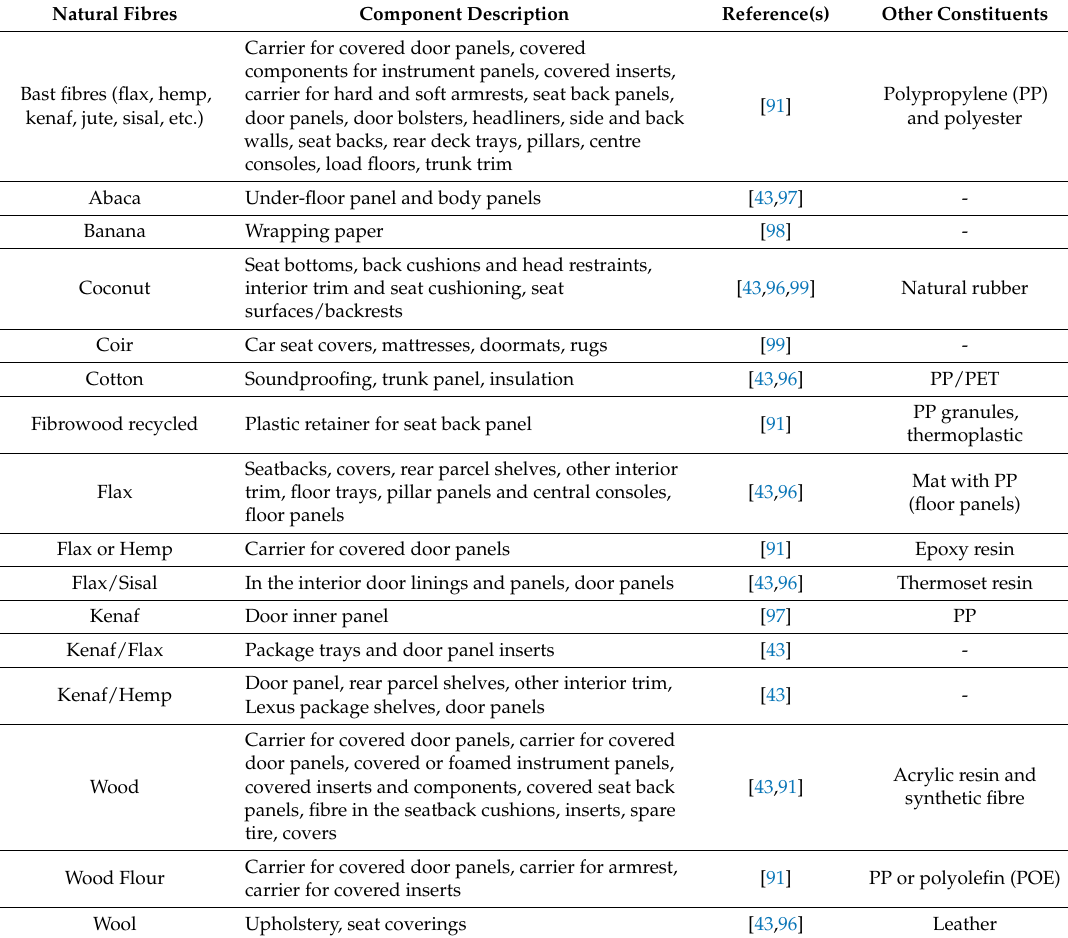
Table 8. Applications of natural fibres in automotive industry. Adapted from: